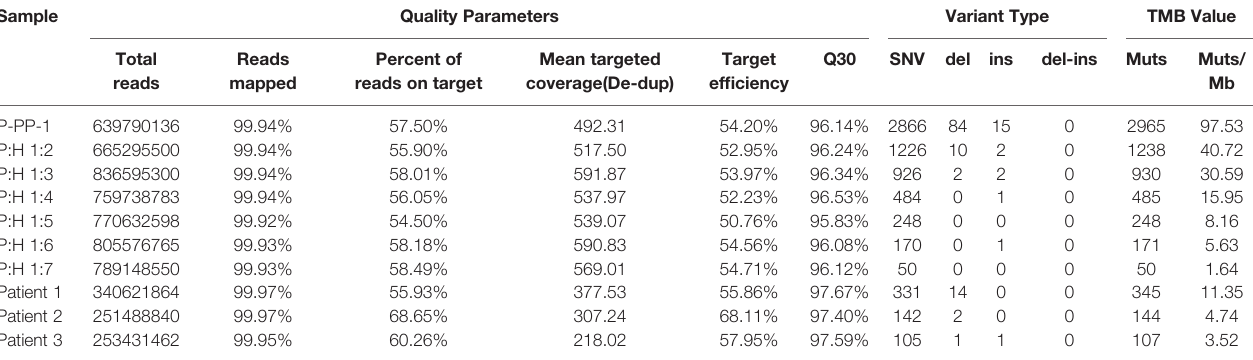
TABLE 2 | Quality control statistics and mutational pattern comparison between the novel reference materials and real clinical samples.